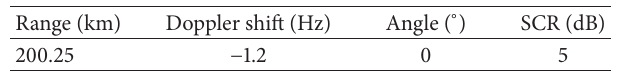
Figure 11: Correlation between the strong target and the weak target within ionospheric clutter. Table 1: Single target situation.